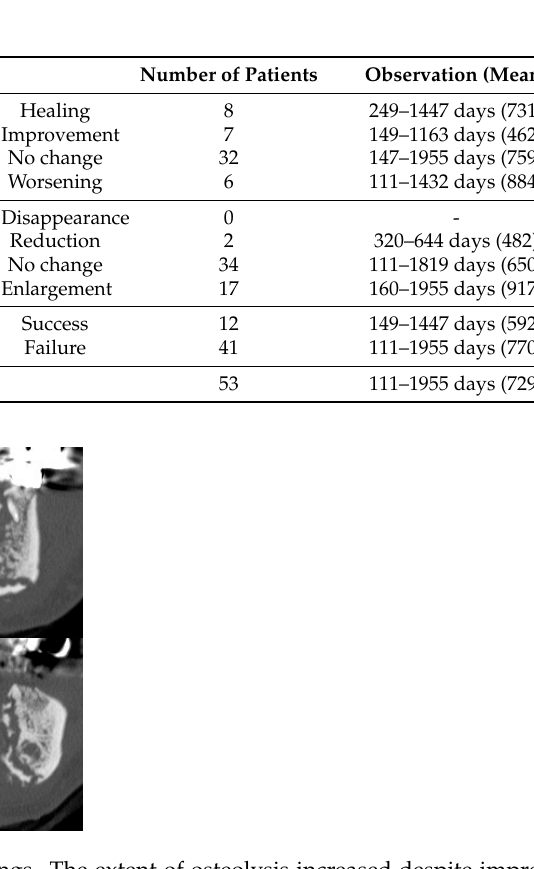
Table 2. Treatment outcome.